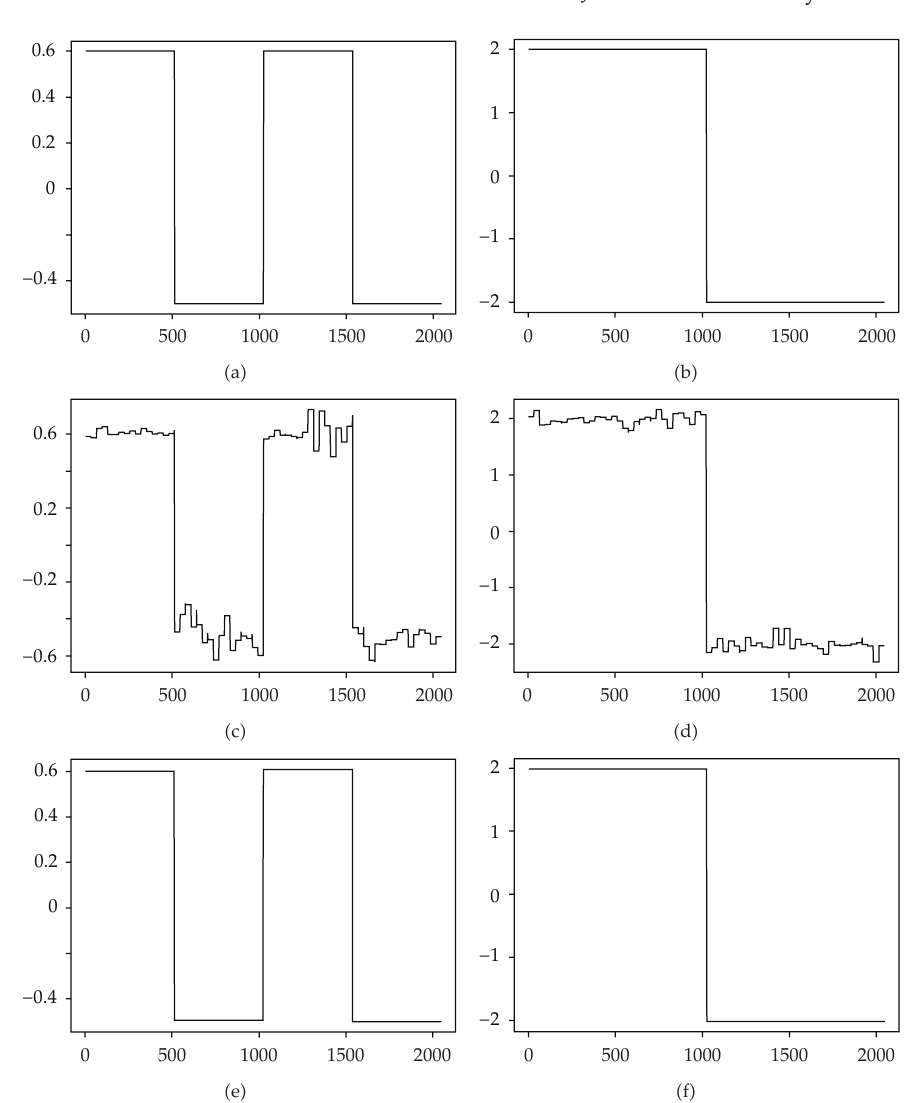
(cid:7) δ (cid:5) d (cid:6) 1 , p q (cid:5) 1 ≤ p , q i and i i i